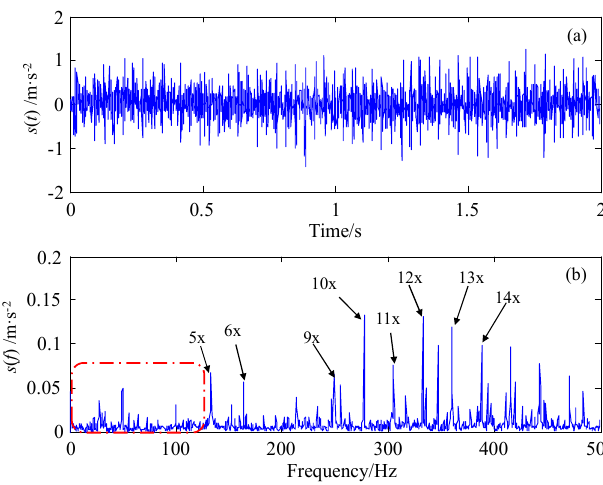
Figure 15. Sliding-bearing test rig for shaft-bending fault experiments.